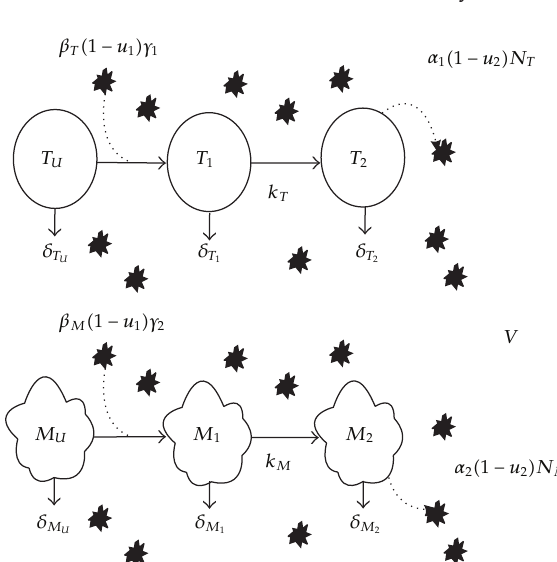
Figure 2: The HIV model with therapy